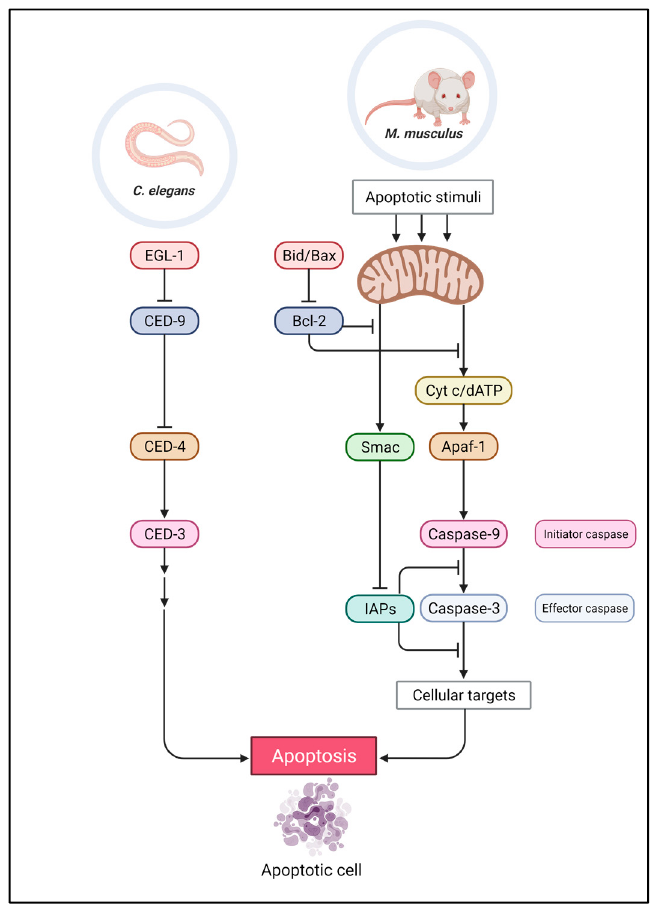
Figure 3. Comparison of apoptosis genetic pathway in C. elegans and mammals. The main genes of the core apoptotic machinery of C. elegans and mice are demonstrated. The illustration is created with BioRender.com.